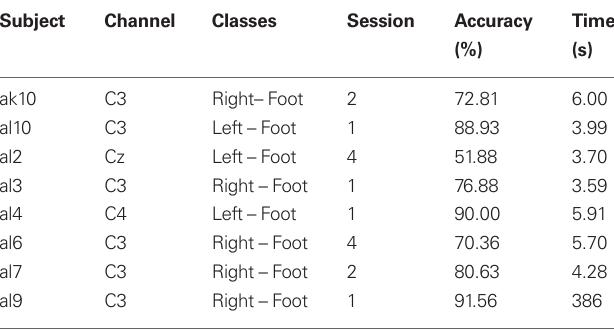
Table 3 | results of the BASKeT feedback experiment.